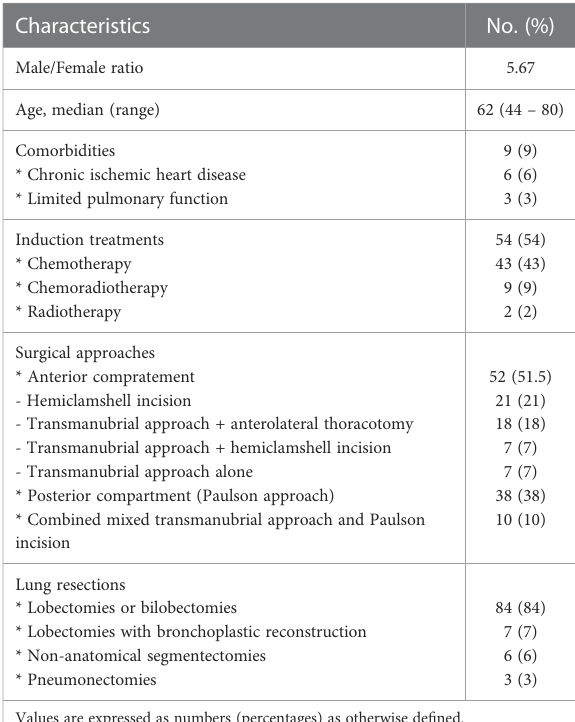
TABLE 1 Demographics and clinical characteristics of the patients with potentially resectable superior sulcus